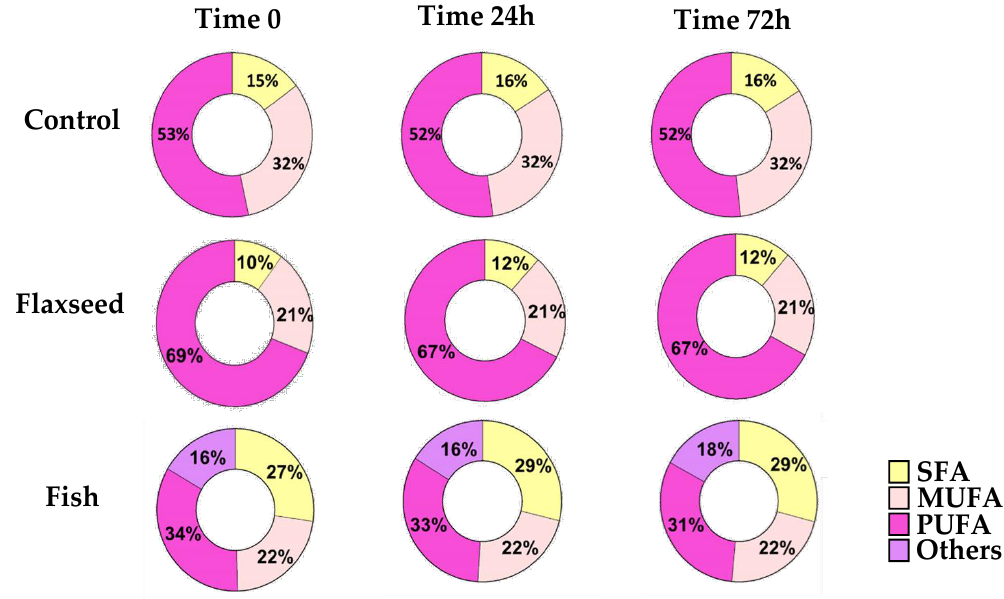
Figure 1. For fatty acid (FA) profiles, lipids were extracted, concentrated, and analyzed by gas chromatography–mass spectroscopy. FA profiles of the diets at three different time intervals (time 0, 24 h, 72 h) for SFAs (saturated fatty acids); MUFAs (mono-unsaturated fatty acids); and PUFAs (polyunsaturated fatty acid).